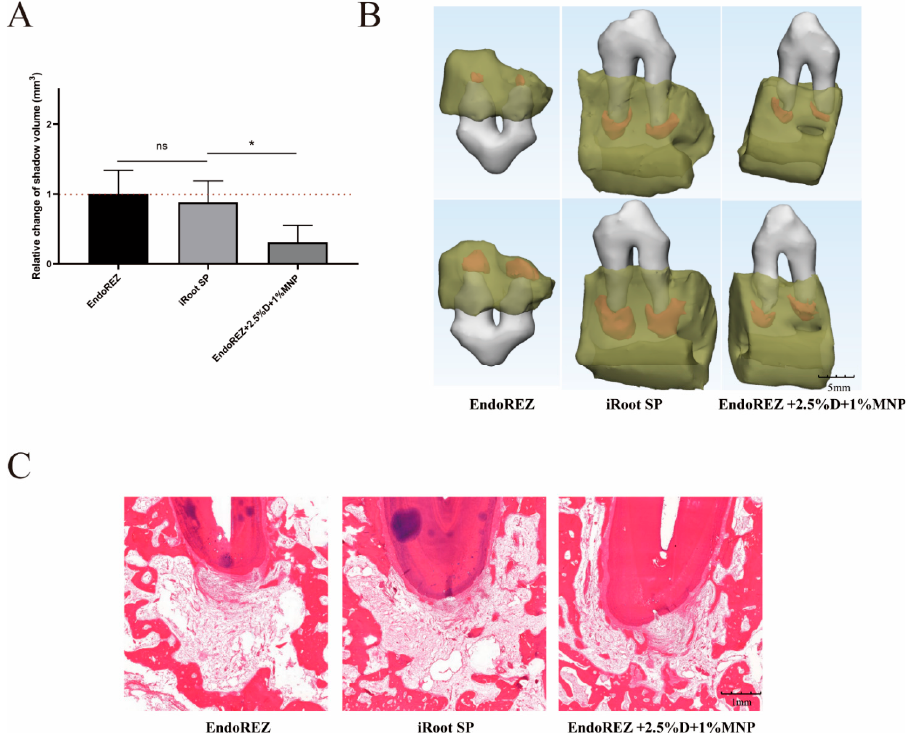
Figure 6. The volume and histopathological section of periapical lesions treated by three sealers. ( A ) Change in apical shadow volume after treatment with three sealers. ( B ) Change in apical shadow volume’s 3D reconstruction. ( C ) Histopathological images after treatment with three sealers. Each value is mean ± SD ( n = 6); * p < 0.05, ns p > 0.05. Table 1. The histopathologic results after treatment with three sealers.